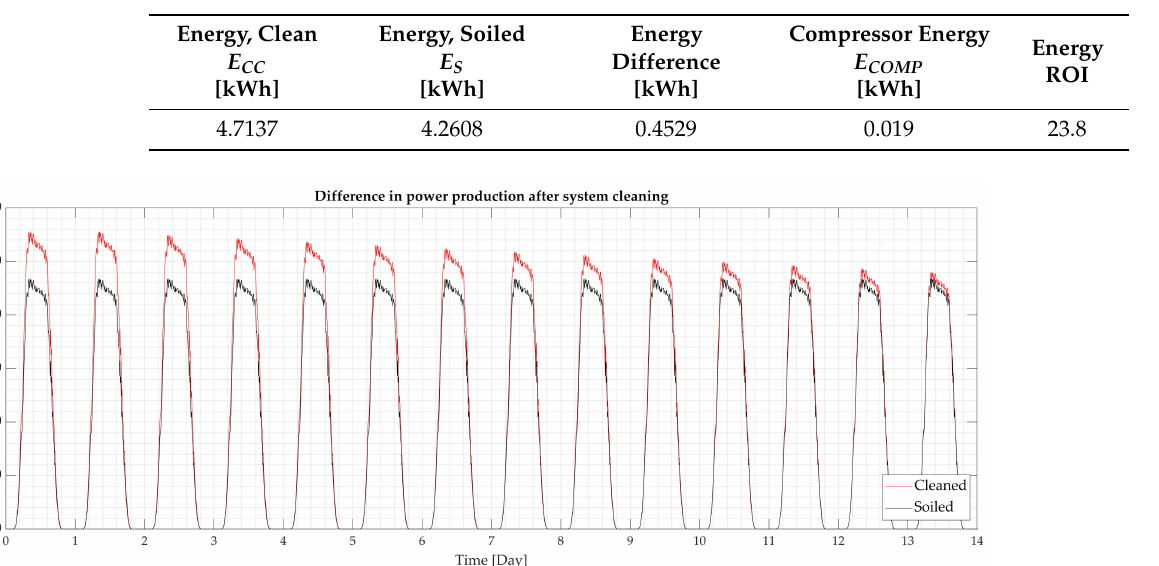
Table 1. Energy ROI for 14 days of PV generation.